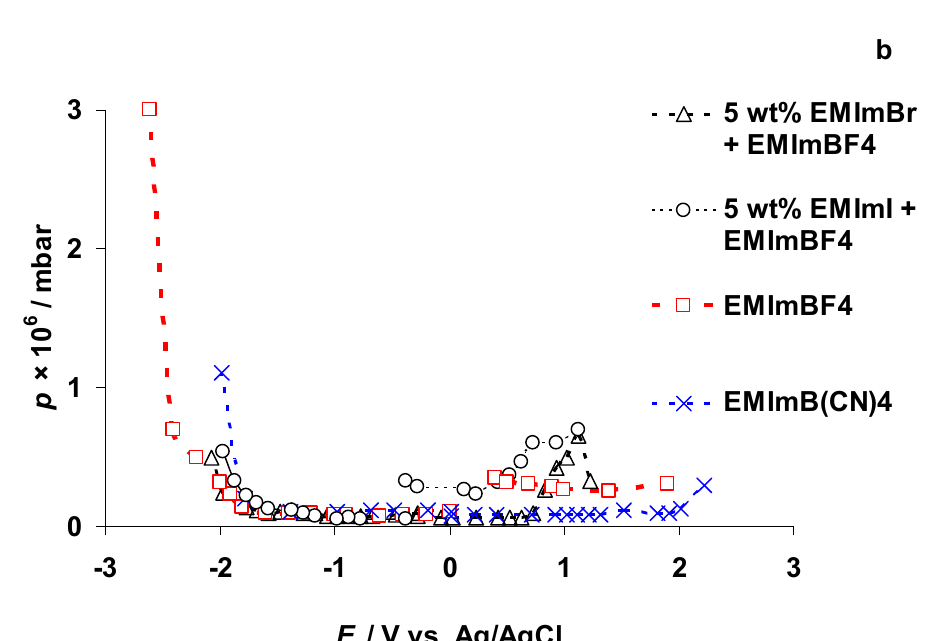
Figure 5. The dependence of gas pressure, p (measured inside the vacuum chamber of the X-ray photoelectron spectrometer), on the negative and positive potentials applied to the C(Mo 2 C) electrode soaked in ( a ) the 5 wt % EMImBr solution in EMImBF 4 and ( b ) the 5 wt % EMImBr solution in EMImBF 4 ( (cid:52) ), EMImB(CN) 4 ( × ), EMImBF 4 ( □ ), and the 5 wt % EMImI solution in EMImBF 4 ( ○ ).